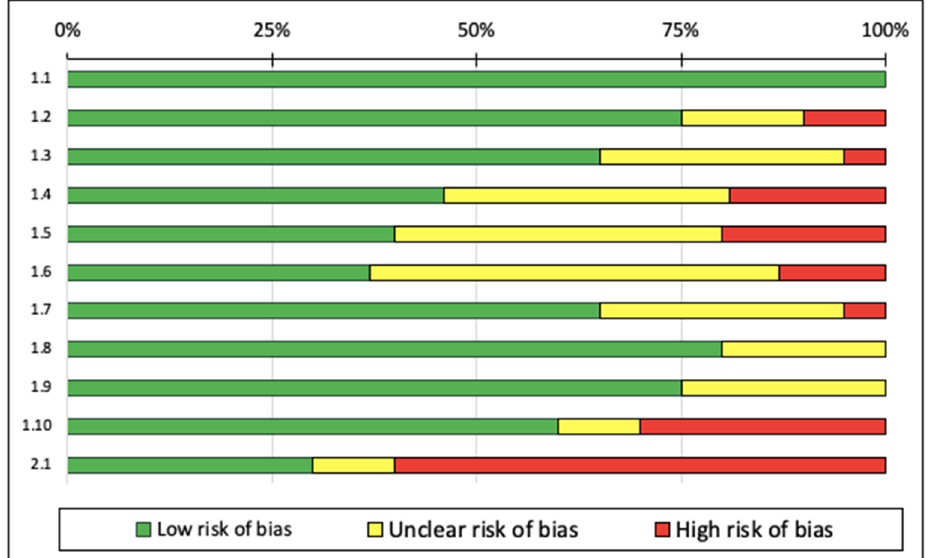
Figure 3. Risk of bias graph. Note: The authors’ judgments on each element of risk of bias are presented as percentages for all included studies. (1.1) the study addresses an adequate and focused question; (1.2) the allocation of participants in the treatment group is randomized; (1.3) an adequate method of concealment is used; (1.4) the design keeps participants and investigators “blind” about treatment allocation; (1.5) the treatment and control groups are similar at the start of the trial; (1.6) the only difference between groups is the investigational treatment; (1.7) all relevant outcomes are measured in a standard, valid, and reliable manner; (1.8) what percentage of individuals or groups enrolled in each treatment arm of the study dropped out before the study completion? (<20% low risk of bias); (1.9) all participants are analyzed in the randomized groups (often referred to as intention-to-treat analysis); (1.10) when the study is conducted at more than one site, the results are comparable for all sites; and (2.1) how well was the study conducted to minimize bias?